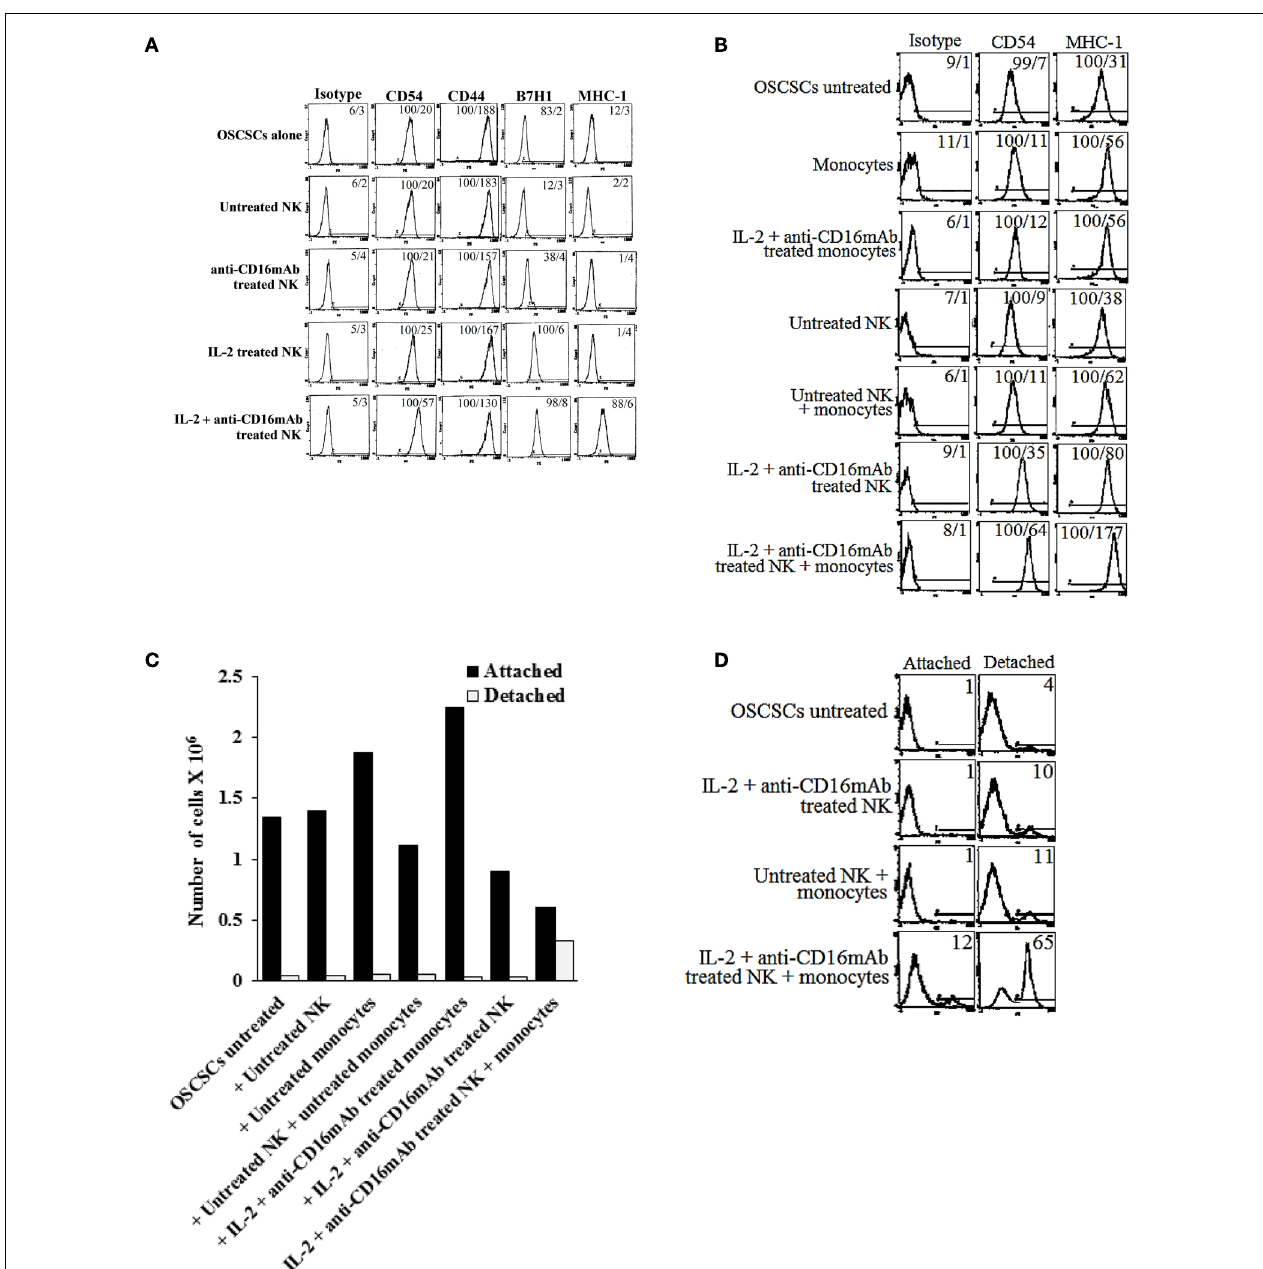
cells were purified from healthy donors and left untreated or treated with IL-2 (1000units/ml), anti-CD16 mAb (3 µ g/ml), or the combination of IL-2 (1000units/ml) and anti-CD16 mAb (3 µ g/ml) in the presence or absence of autologous monocytes (1:1 ratio of NK:monocytes) for 24h.Thereafter, the same amounts of supernatants from different treatments of NK cells were removed and added to OSCSCs. After 5days of incubation with the NK cell supernatants, OSCSCs were washed with 1 × PBS, and the expression of CD54 and MHC-1 were assessed after staining with the PE-conjugated antibodies using flow cytometry (B) . Isotype control antibodies were used as controls.The numbers on the right hand corner are the percentages and the mean channel fluorescence intensities for each histogram.